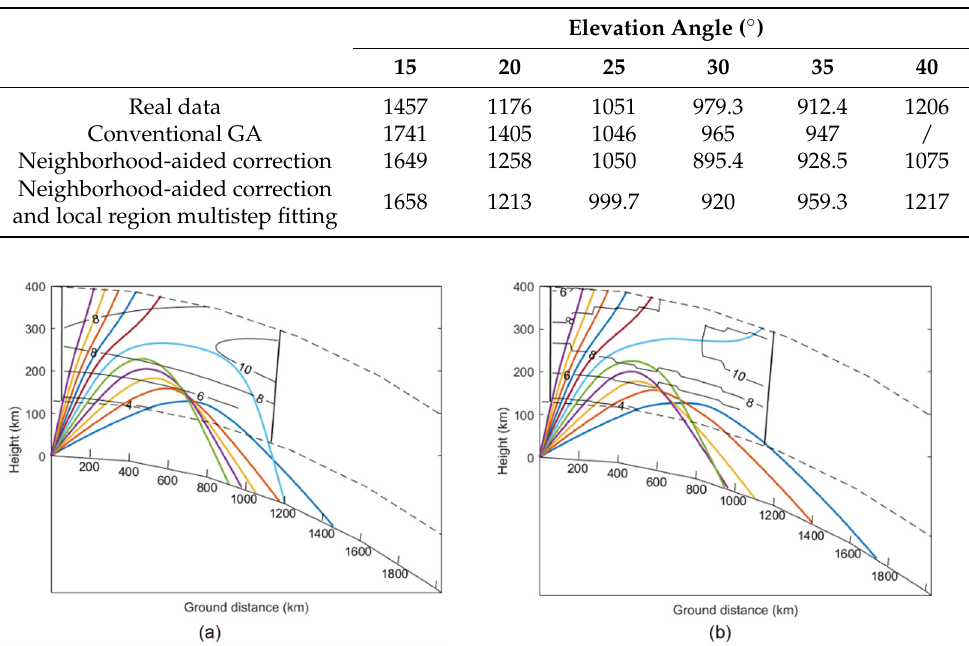
Table 3. Ground distance of the ray tracing results